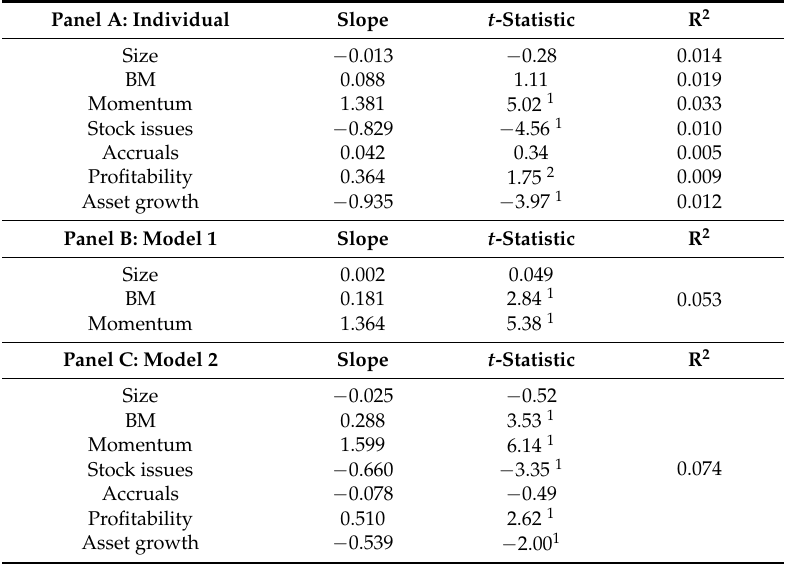
Table 5. Fama and MacBeth (1973) Cross-Sectional Regressions: Large Stocks. Panel A: